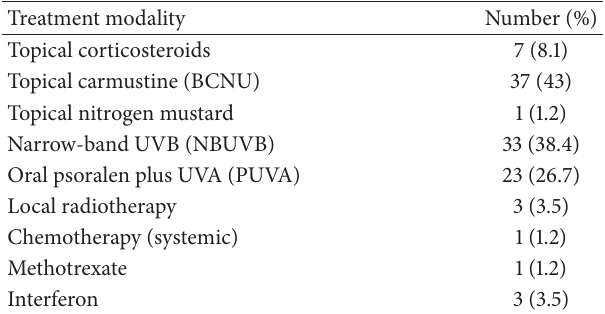
Table 4: Treatment modalities used for mycosis fungoides in 86 Iranian patients a